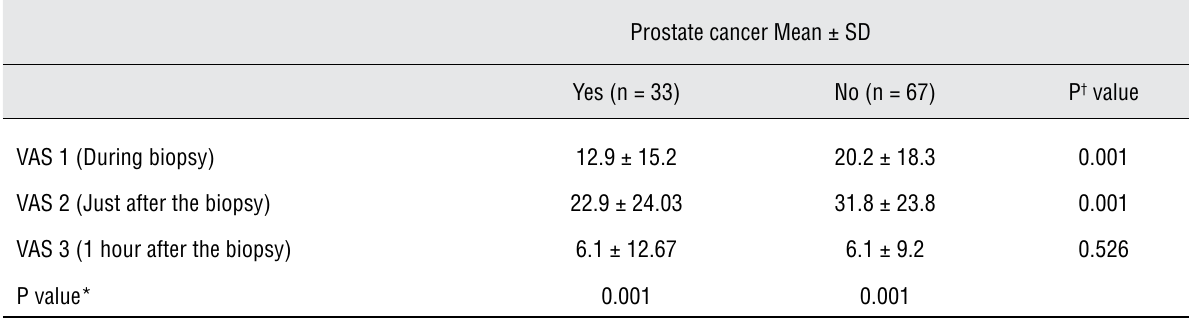
Table 3 - Distribution of pain scores according to the existence of prostate